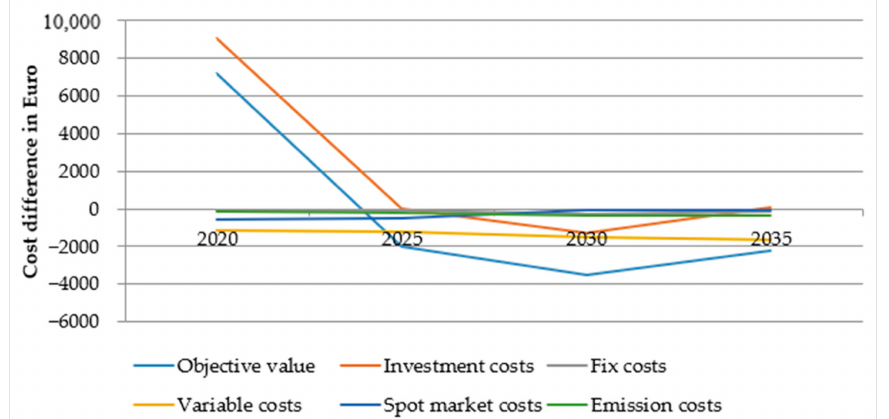
Figure 12. Cost difference between the two approaches over the optimization period for the RETRO scenario with high CO 2